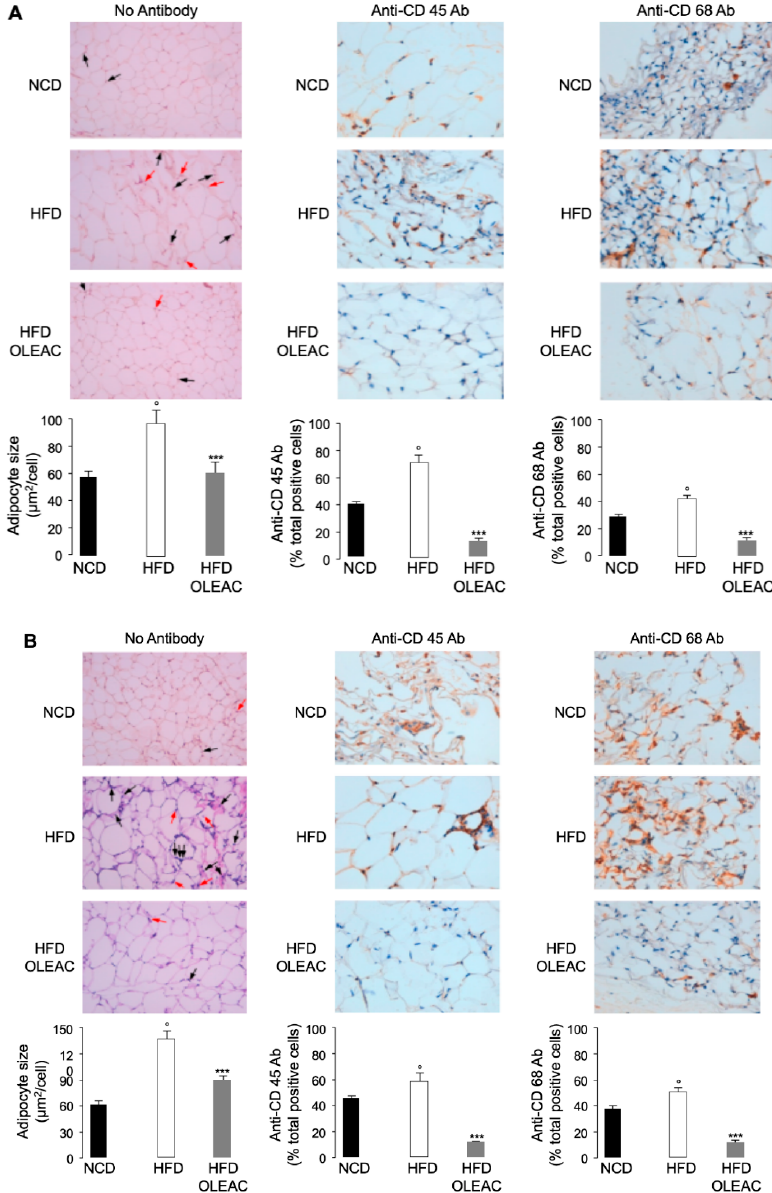
Figure 1. Effects of oleacein on mice adipocytes. Representative color images of hematoxylin and eosin stained fat cells and immunostaining for CD 45 and CD 68 in the abdominal fat tissue of normocaloric diet (NCD) mice and high-fat diet (HFD)-fed mice of the first ( A ) and second ( B ) set of experiments, either untreated (HFD) or treated with oleacein (HFD-OLEAC). NCD, mice under normal caloric diet. Black and red arrows indicate the accumulation of lymphocytes and macrophages within the fat tissue, respectively (200× magnification). Adipocyte diameter and the percentage of total positive cells for CD 45 and CD 68 in abdominal fat tissue are shown in bar graphs. Values are expressed as means ± SD. *** p < 0.001 vs. HFD; ° p < 0.01 vs. NCD.